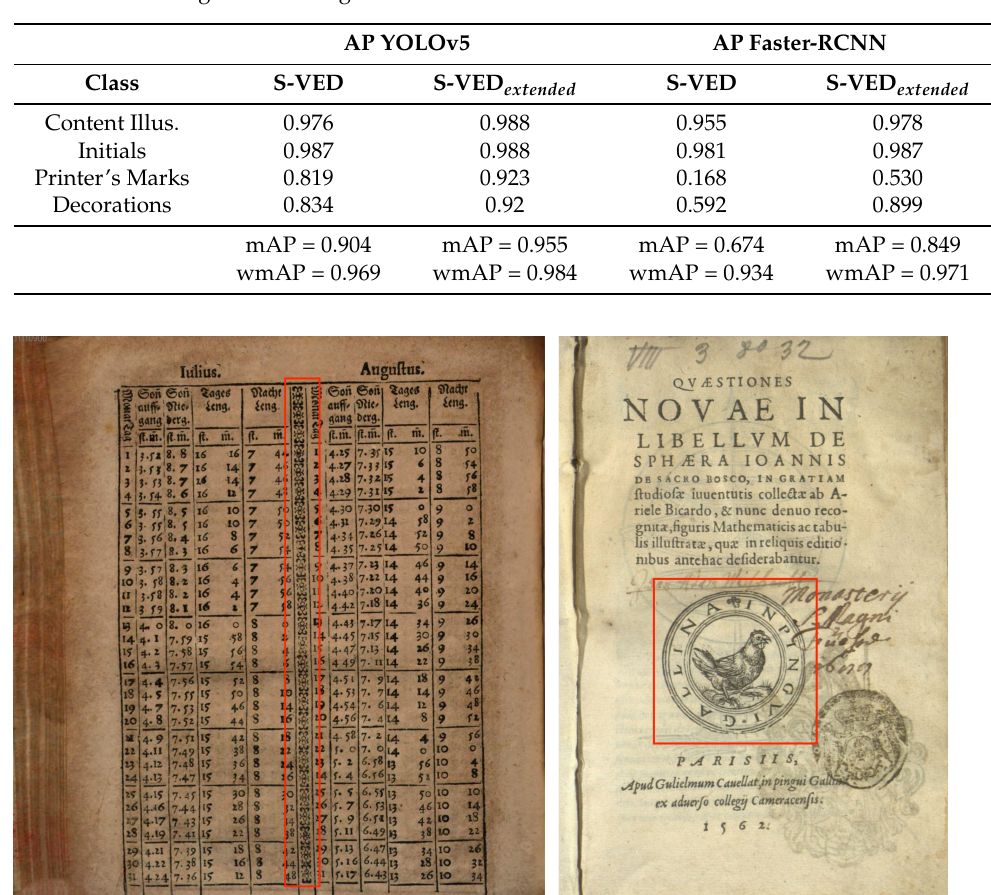
Table 3. Average precision results for the four different types of visual elements as achieved by the YOLOv5 model with its best performing input image resolution 640 × 640 and the Faster-RCNN model with its best performing input image resolution 1280 × 1280. The mean average precisions are reported as the standard mean (mAP) over the APs of the classes and the weighted mean (wmAP), where APs are weighed according to the relative number of instances of the class.